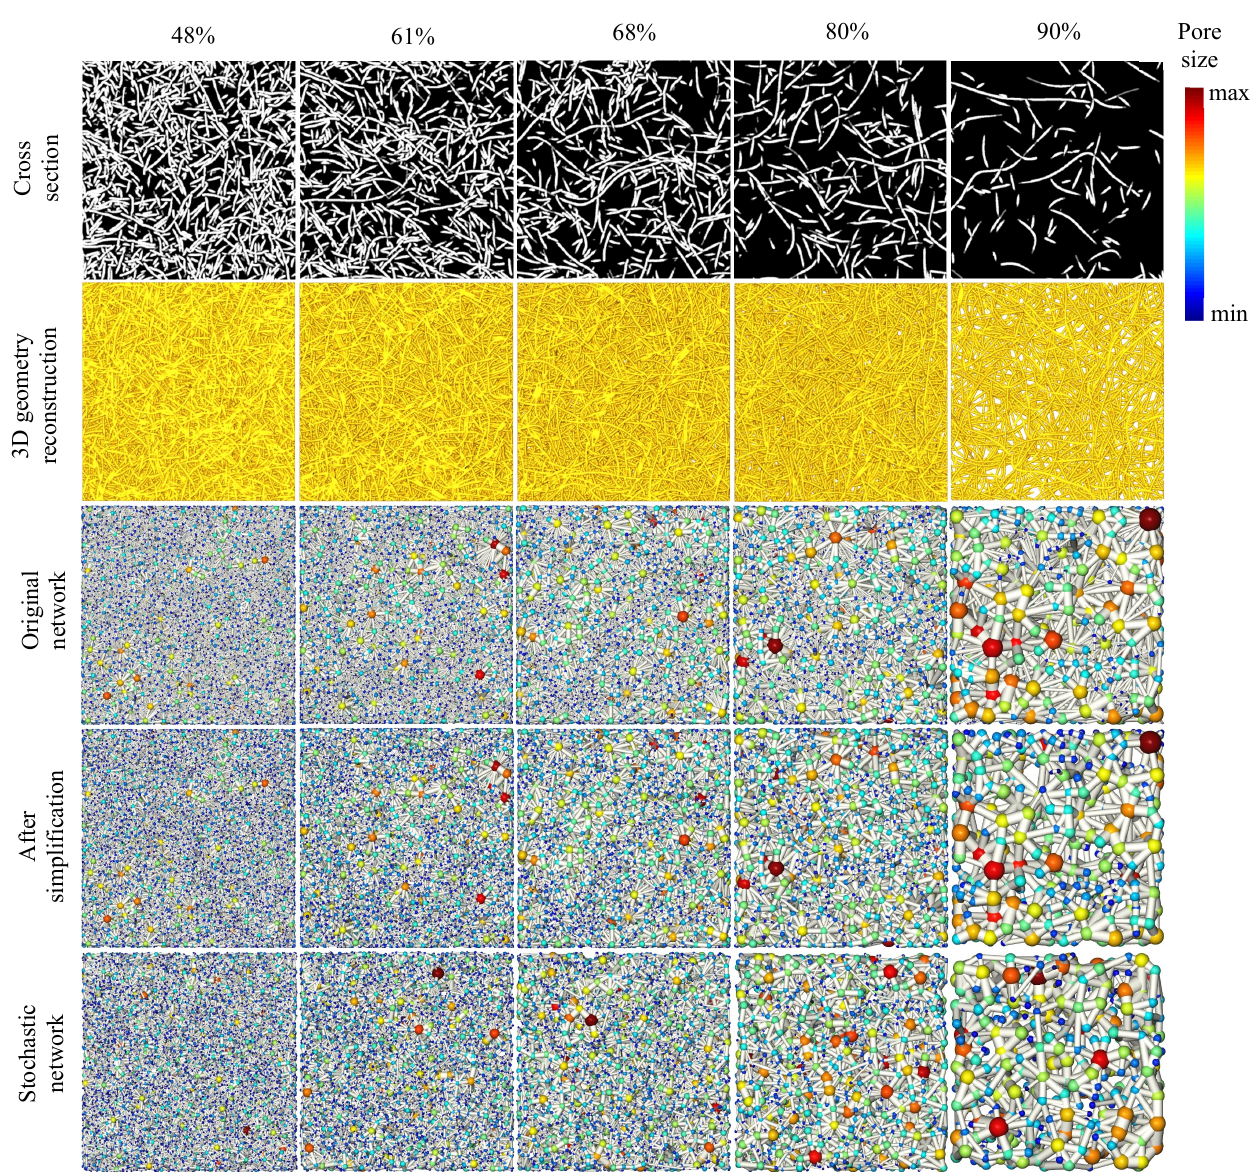
Figure 2. In the column direction from left to right: fiber mat of porosities of 48%, 61%, 68%, 80%, and 90%; in the row direction from top to bottom: the cross-section image, the 3D geometry reconstruction, the extracted pore network of the void space, the network after simplification, and the stochastic network. The 3D image is of 400 × 400 × 100 (x × y × z) pixel resolution, with 5 pixels in the fiber’s